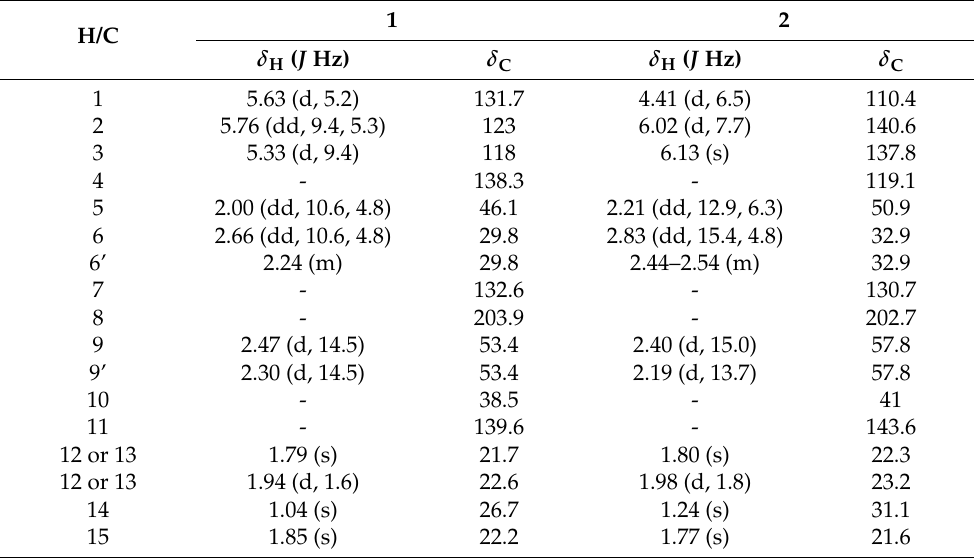
Table 2. 1 H and 13 C NMR spectra data for 1 and 2 isolated from the essential oil of E. uniflora